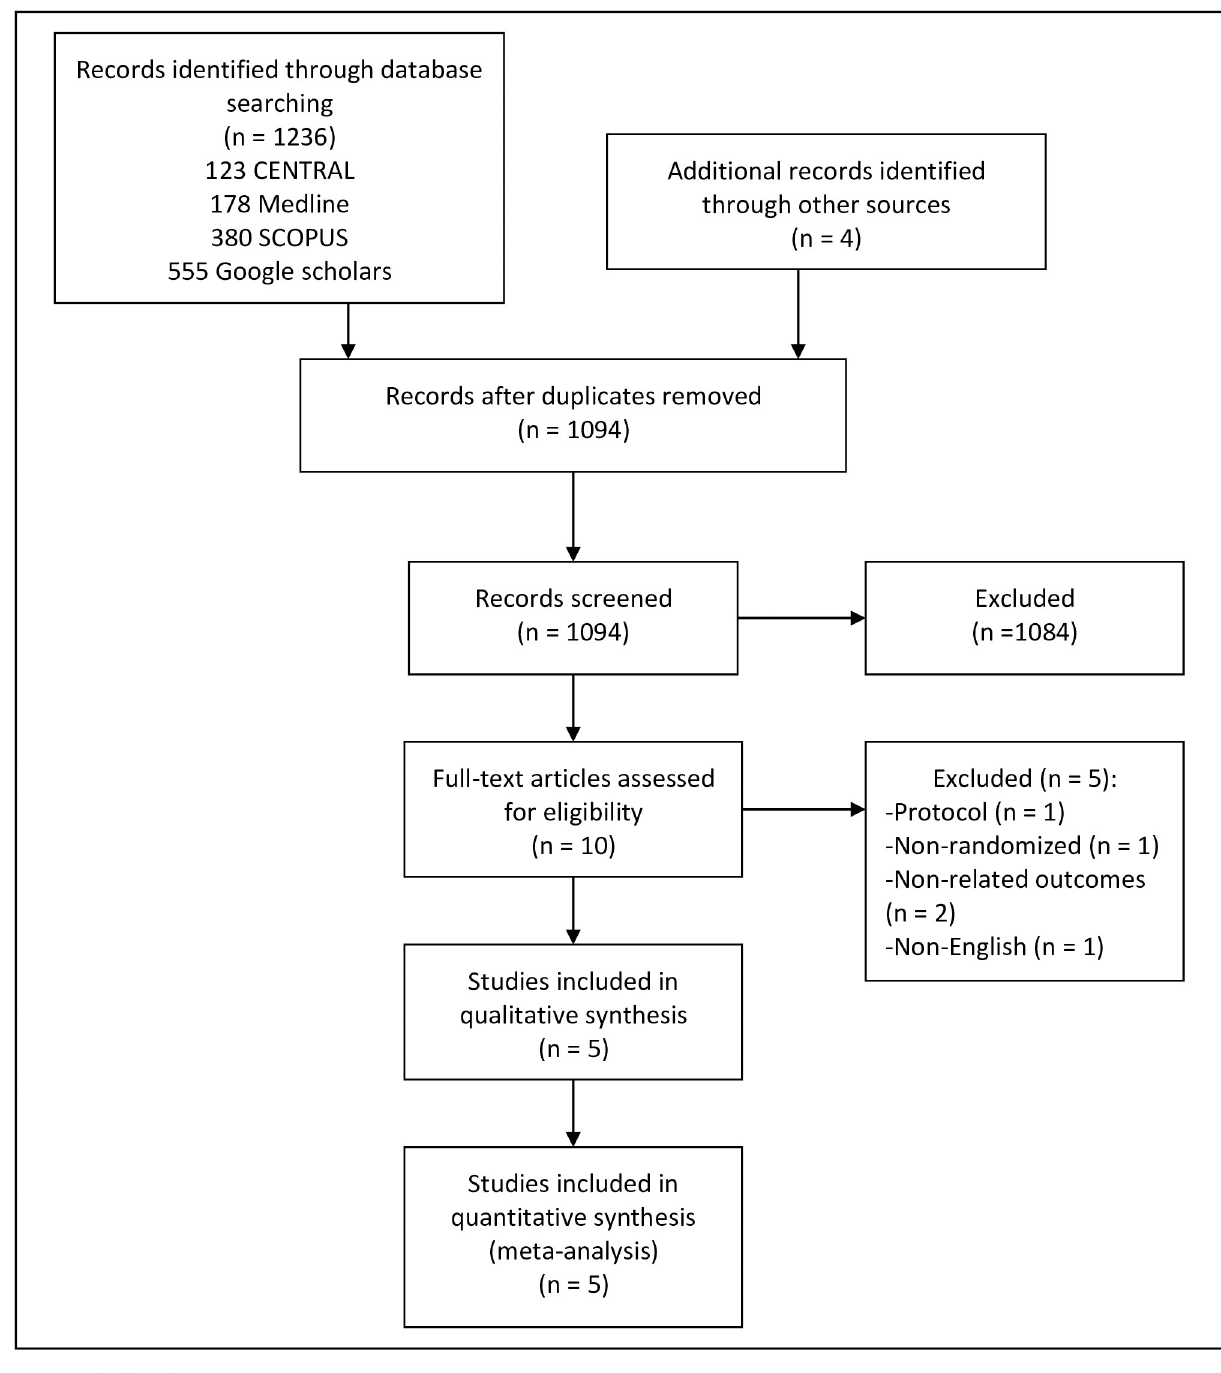
Fig 1. Study flow